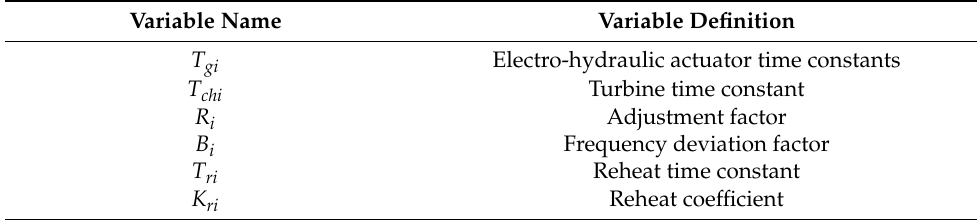
Figure 1. Frequency control system model of the TPU. Table 1. Variable Table.